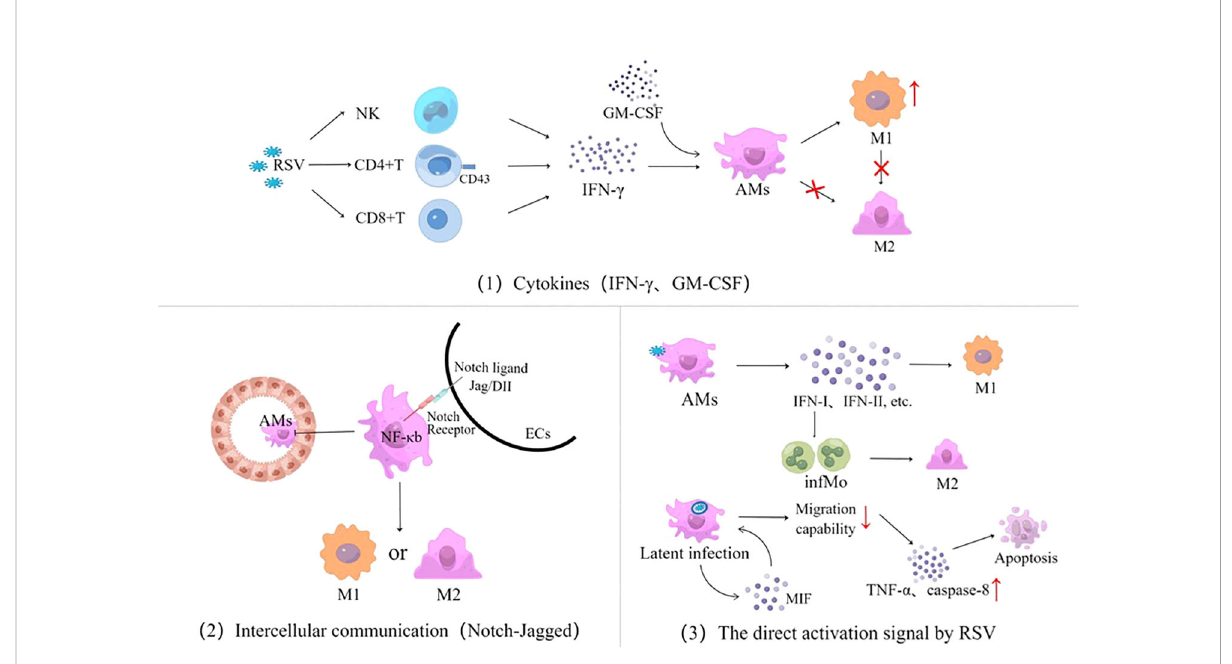
FIGURE 4 Three signaling pathways for AM polarization activated by RSV infection, cytokines represented by IFN and GM-CSF, intercellular communication using the Notch-Jagged pathway as an example, and the direct activation signal by RSV. RSV, respiratory syncytial virus; NK, natural killer cells; IFN, interferon; GM-CSF, granulocyte – macrophage colony-stimulating factor; AMs, alveolar macrophages; ECs, epithelial cells; M, macrophage; infMo, in fl ammatory monocytes; MIF, macrophage migration inhibitory factor; TNF- a , tumor necrosis factor- a